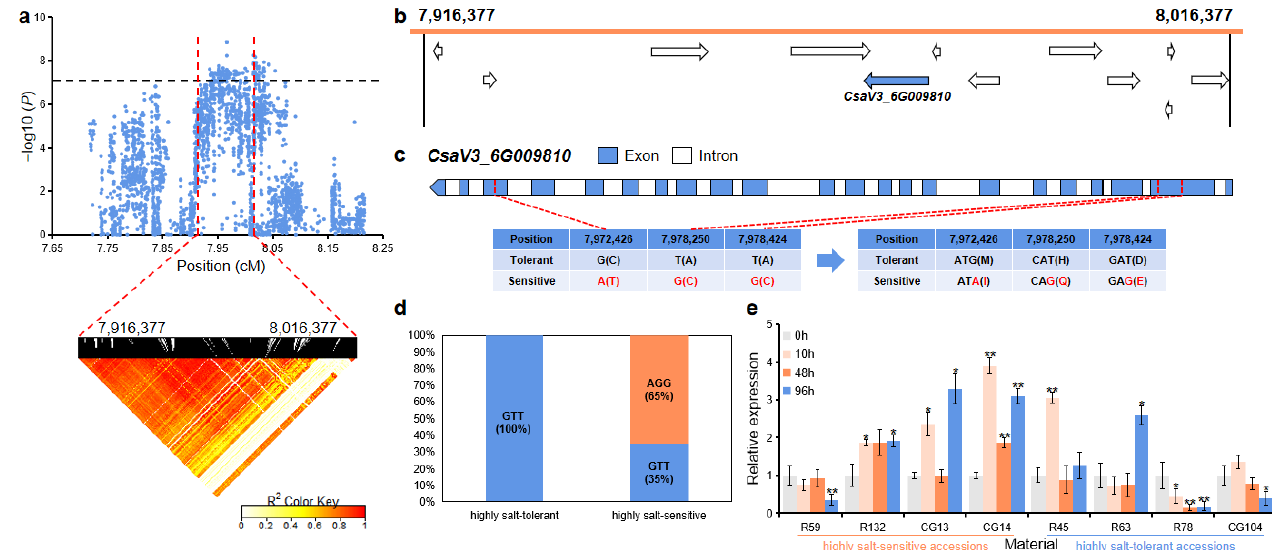
Figure 9. Identification of the candidate gene that as related to salt tolerance for the locus gST6.1 . ( a ) Manhattan plot and LD heatmap of gST5.1 . The black dashed line represents the significance threshold and the red dashed lines represent the candidate region (100 kb). ( b ) A total of 12 functional annotated genes were predicted in the gST6.1 candidate region. The blue arrow indicates that the functional annotation of the gene which is related to salt tolerance. ( c ) Gene structure of CsaV3_6G009810 . Blue rectangles and white rectangles indicate exons and introns, respectively. ( d ) Orange and blue blocks represent the proportion of AGG and GTT haplotype in the highly salt-tolerant or highly salt-sensitive accessions, respectively. ( e ) qRT-PCR was used to detect the expression changes of CsaV3_6G009810 in the highly salt-sensitive accessions (R59, R132, CG13, and CG14) and highly salt-tolerant accessions (R45, R63, R78, and CG104) after salt treatment (0 h, 10 h, 48 h, and 96 h). Significant difference (* p < 0.05, ** p < 0.01).